Question: Briefly state, in one sentence, what is plotted here.
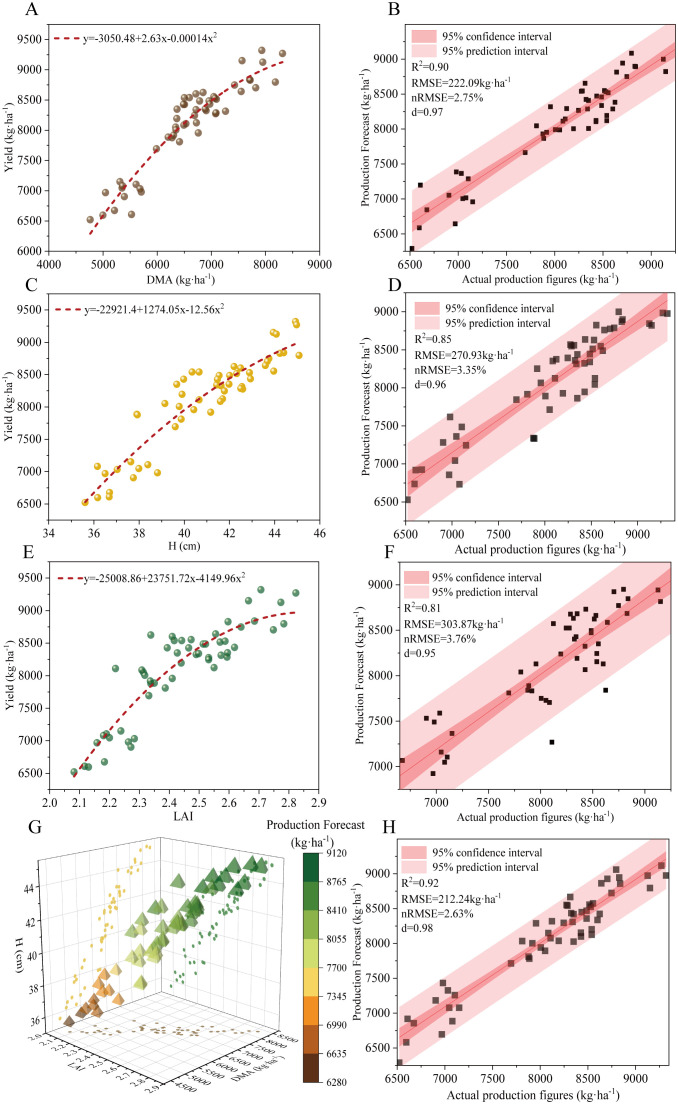
Answer: Analysis of the fitting of physiological growth models for winter wheat. (A, B) show the fitting and validation of the dry matter accumulation model for winter wheat. (C, D) show the fitting and validation of the plant height model for winter wheat. (E, F) show the fitting and validation of the leaf area index model for winter wheat. (G, H) show the fitting and validation of the multivariate stepwise regression model for winter wheat.